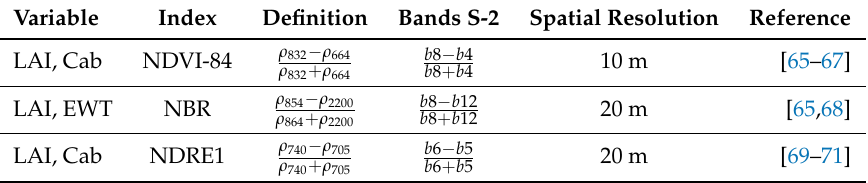
Table 1. Selected indices. Cab = Chlorophyll, LAI = Leaf Area Index, EWT = Water Content.